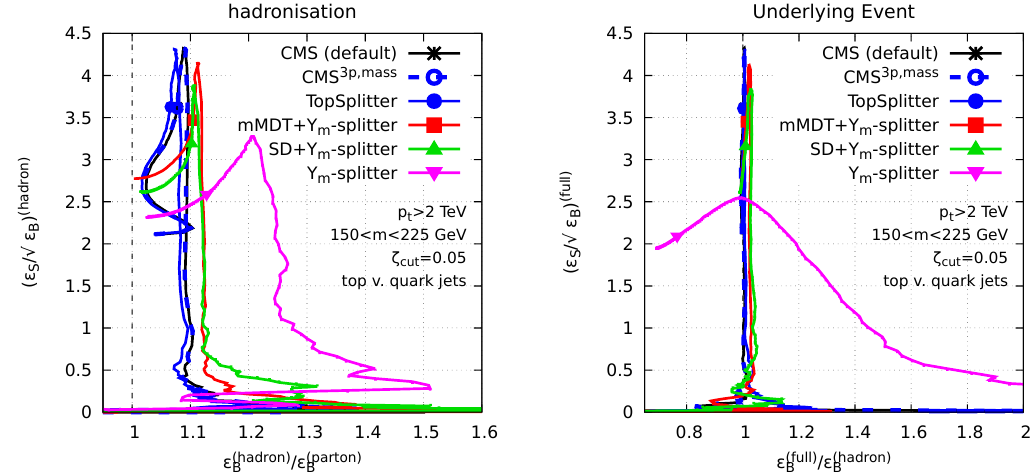
Figure 11. Both plots show how the sensitivity to non-perturbative e(cid:11)ect ( x axis) and the dis- criminating power ( y axis) evolve when varying the cut on m min for di(cid:11)erent taggers. Left: e(cid:11)ects observed when switching on hadronisation, i.e. going from parton level to hadron level. Right: e(cid:11)ects observed when including the Underlying Event. The symbols correspond to m min = 50 GeV.